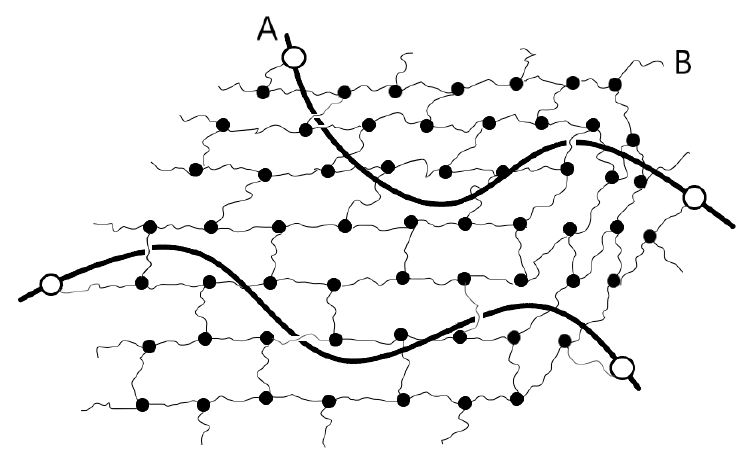
Figure 4. Schematic view of a part of phenolic foam showing an entanglement of basic phenolic resin (thin lines) with polyether phenolic resin (thick lines).